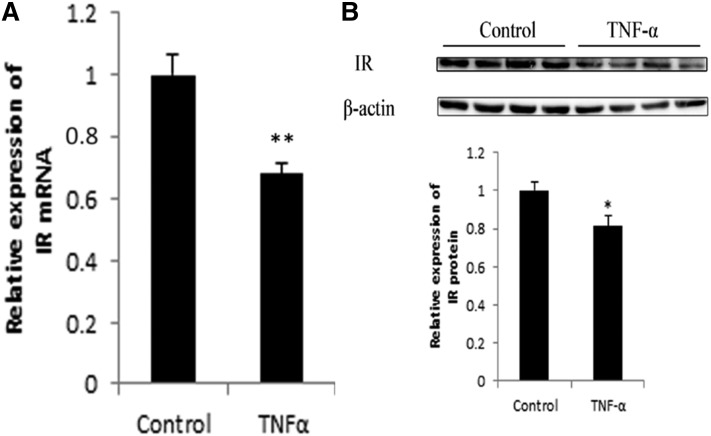
TNF-α suppresses IR mRNA and protein expression. A: Real-time PCR analysis of IR mRNA after TNF-α treatment. β-actin was used as an internal reference (** P < 0.01, n = 6). B: Western blot and gray-scale scanning analysis of IR after TNF-α treatment (* P < 0.05, n = 4).